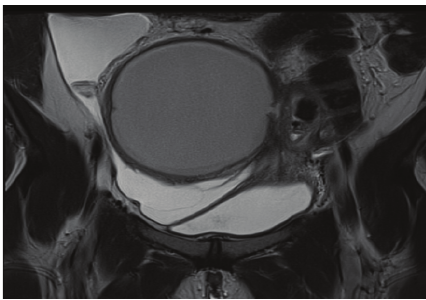
Figure 1: RMI coronal view, T2 sequence, and abscess with fistula on its left side.